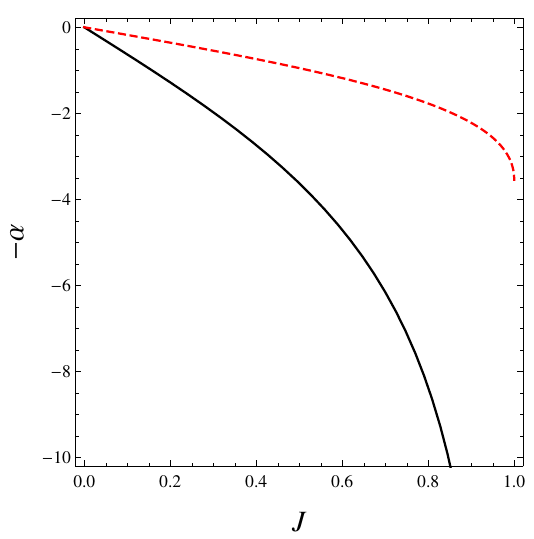
Figure 5. Plots of stability curves − α ( J ) at fixed M of standard (black solid) and formal logarithm (red dashed) approaches in the microcanonical treatment. No turning point appears on either stability curve.